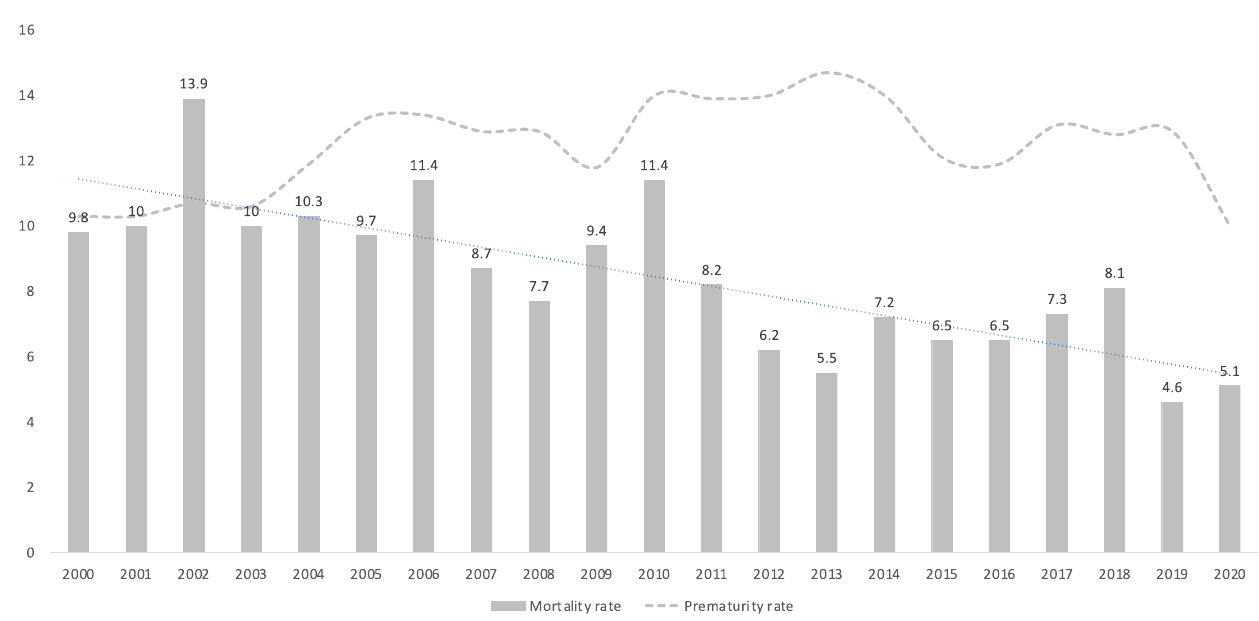
Figure 1. Perinatal mortality (‰) and prematurity rates (%) per year of study. The distributions of the 592 cases of very early PPROM per year and g.a. at diagnosis are shown in Figure 2. Mean maternal age in the period was 31.5 years, with a clear trend to increase over the years ( r = 0.14, p < 0.001), so that mean maternal age was 2.4 years higher in the period 2015–2020 when compared with the first five-years period (32.8 against 30.4 years, p < 0.01). We also found a negative correlation between the mean age of the participants and the gestational age at PPROM diagnosis ( r = − 0.12; p < 0.01).